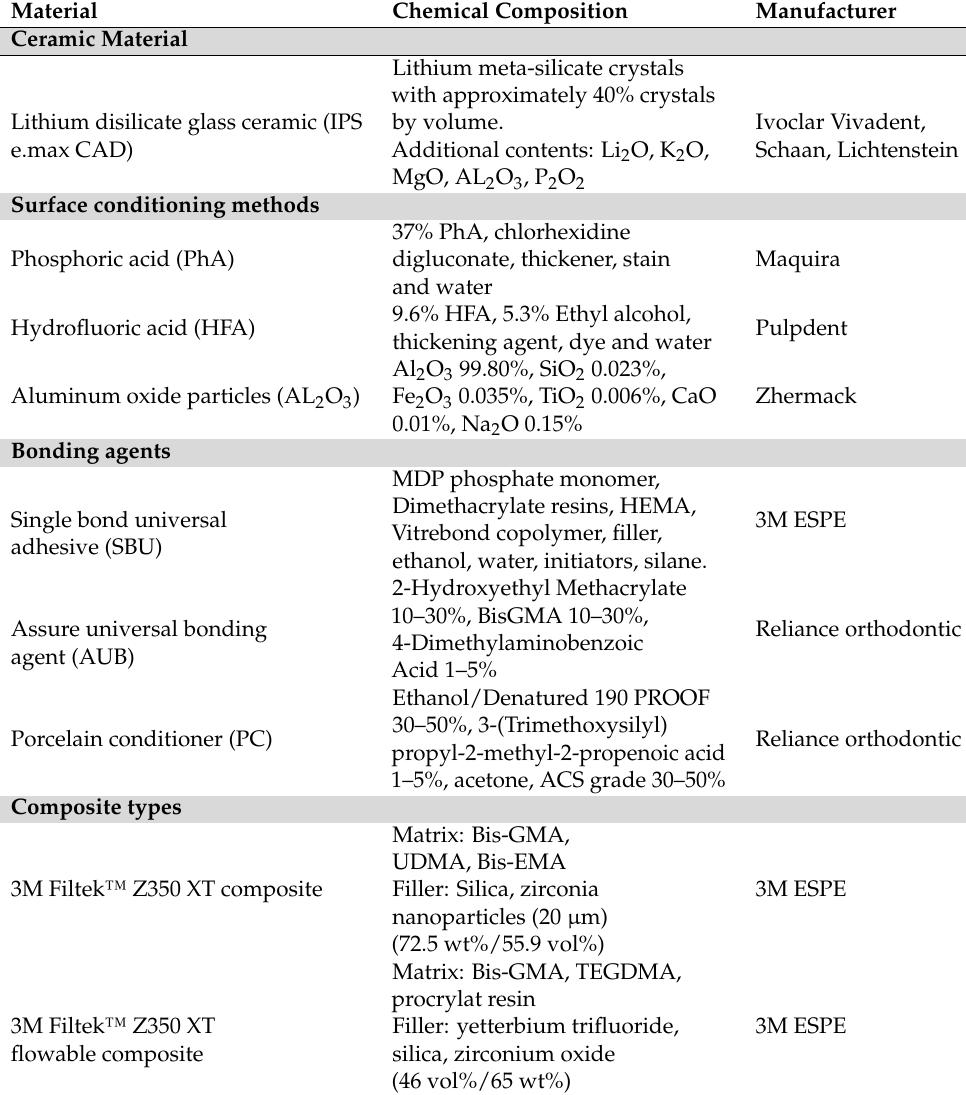
Table 1. Materials used in this study with their chemical compositions and manufacturer